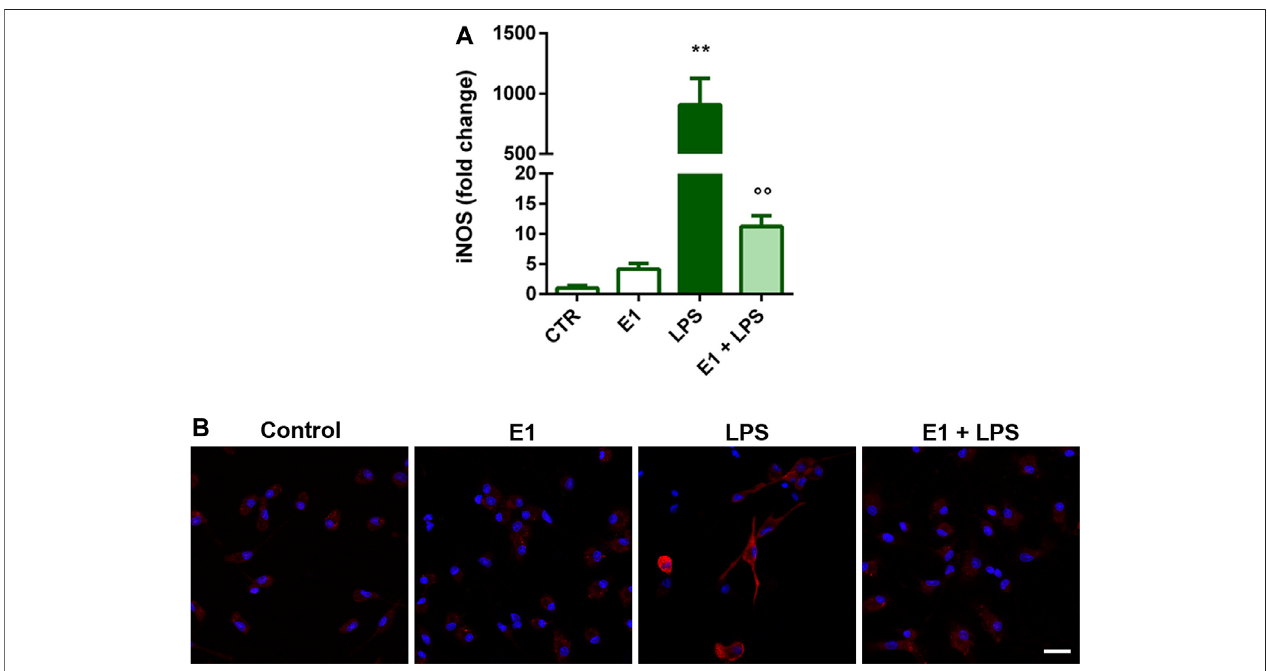
FIGURE3| Effectofpre-treatmentwithSpirulinaextractoniNOSgeneandproteinexpressioninLPS-stimulatedcorticalmicroglia.Microgliawereculturedfor24 h in 10% serum-containing medium, which was replaced with serum-free medium before pre-treatment with 100 μ g/mL E1 followed by stimulation with 100 ng/ml LPS. (A) iNOS mRNA levels were quanti fi ed by real-time PCR.Dataare presented as means ± SEM ( n (cid:1) 3 intriplicate). ** p < 0.01 compared to control cells; °° p < 0.01 versus LPS stimulation. One-way ANOVA followed by Sidak ’ s multiple comparison test. (B) Microglia were stained with anti-iNOS antibody (red) and nuclei with DAPI (blue). Experiments were performed three times and representative immuno fl uorescence images are shown. Scale bar, 20 μ